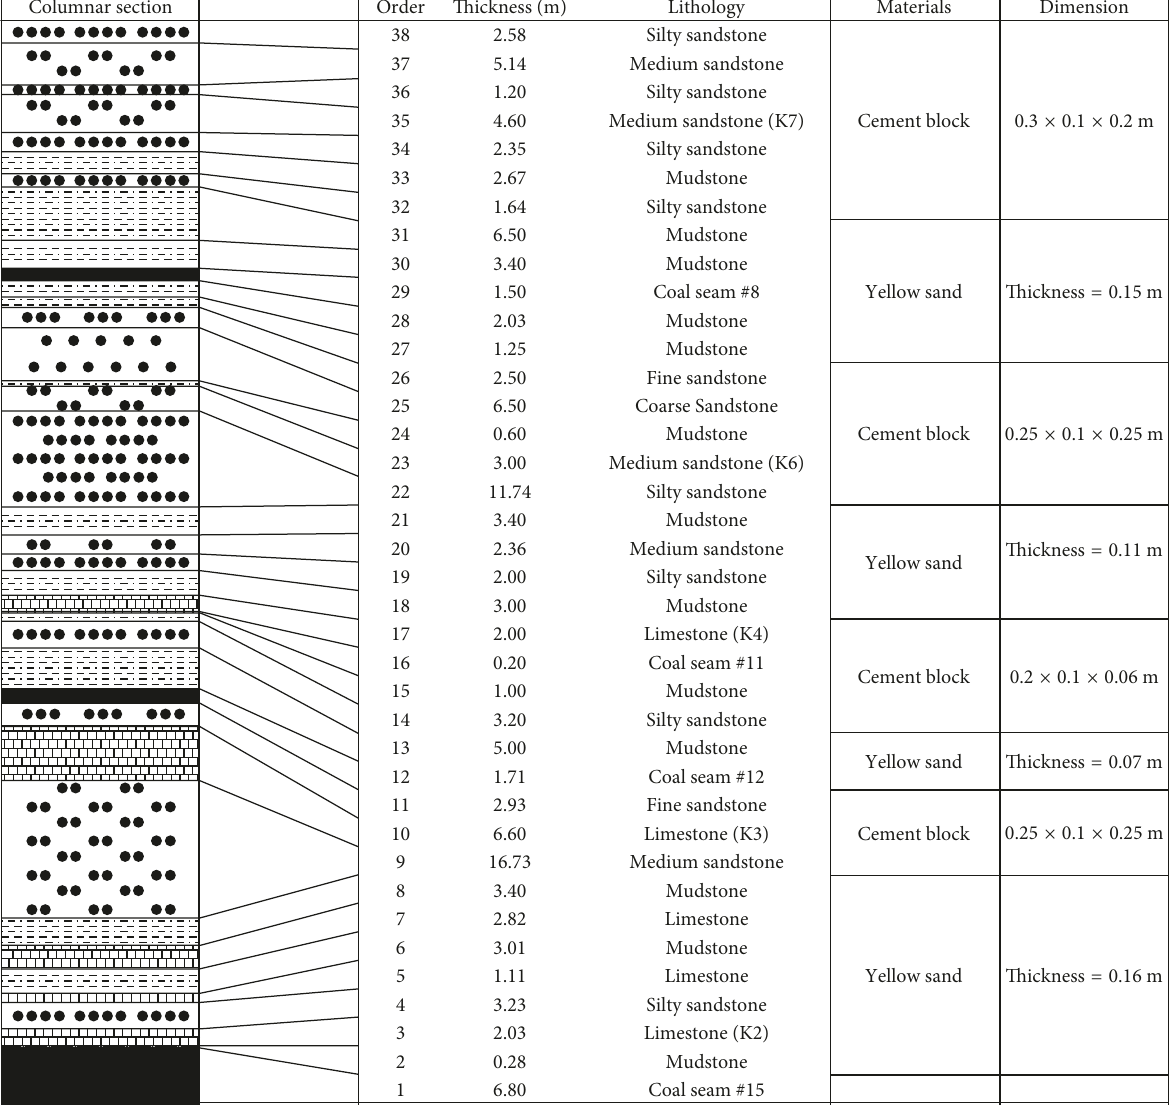
Figure 11: Schematic diagram of the trapping foam board and yellow